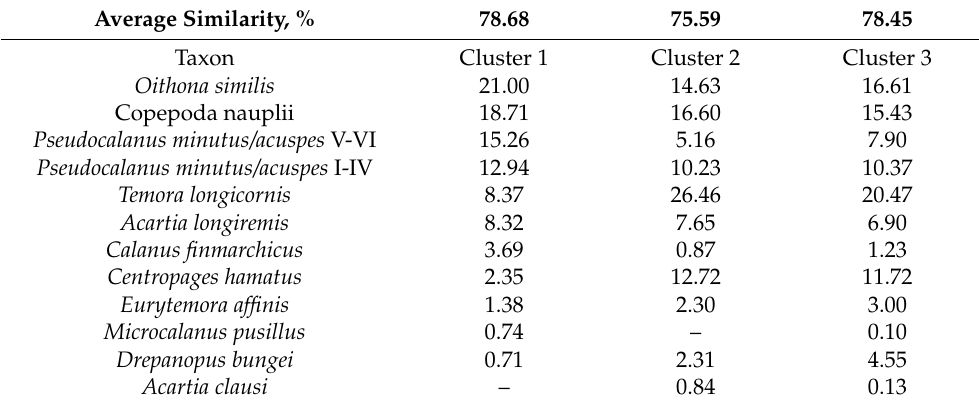
Table 4. SIMPER analysis: contributions (%) of copepods to similarities of each group delineated with cluster analysis based on the species abundance in the south-eastern Barents Sea in summer 2012. Average Similarity,